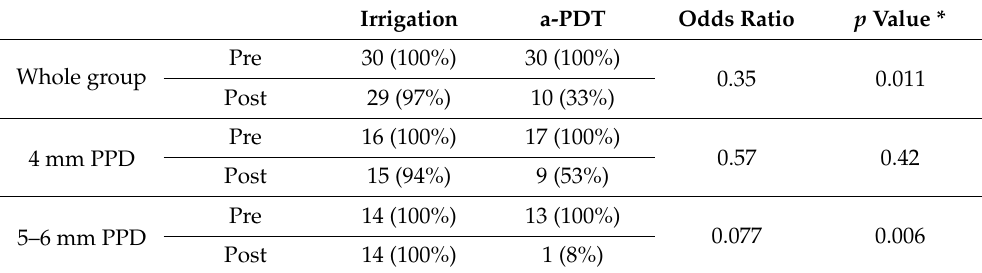
Table 2. Number of BOP-positive sites before and after treatment. Irrigation